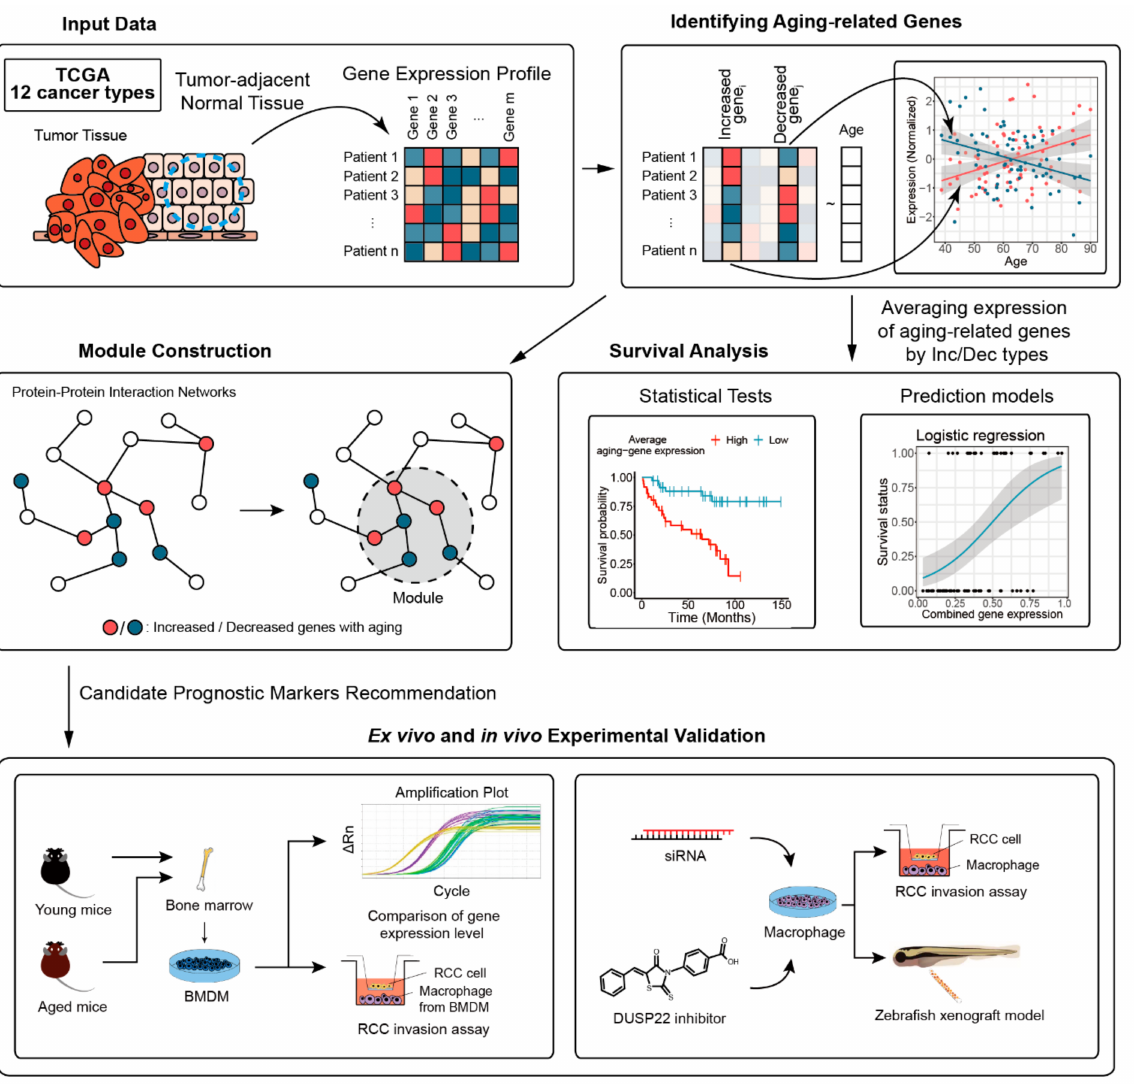
Figure 1. Overall workflow of the study. Aging-related genes were identified from 12 TCGA transcriptomic datasets by performing linear regression. We constructed modules containing aging-related genes to find representative clusters associated with aging. We analyzed relationships between aging-related genes and survival of patients by statistical tests and prediction models. Ex vivo and in vivo experiments using an animal model of aging were carried out to validate aging-related expression and its effect on cancer cell invasion and